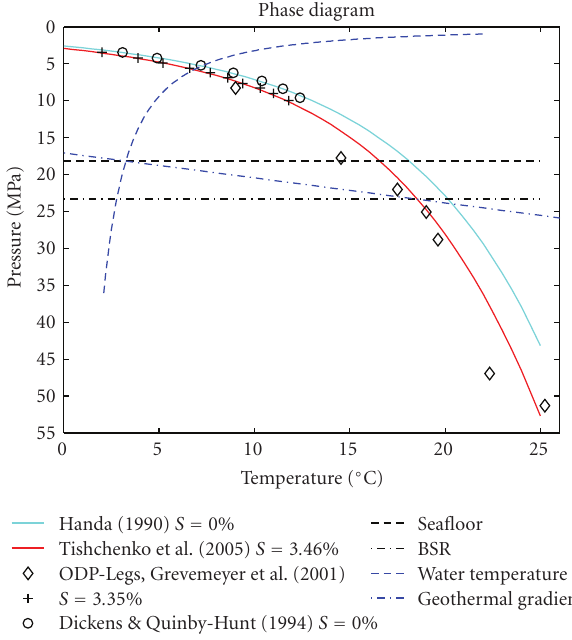
Figure 7: Methane hydrate stability curve of Handa [65] for pure water and Tishchenko et al. [22] for bottom water with a salinity of 3.46%, laboratory data of Dickens and Quinby-Hunt [45] and ODP data [20].